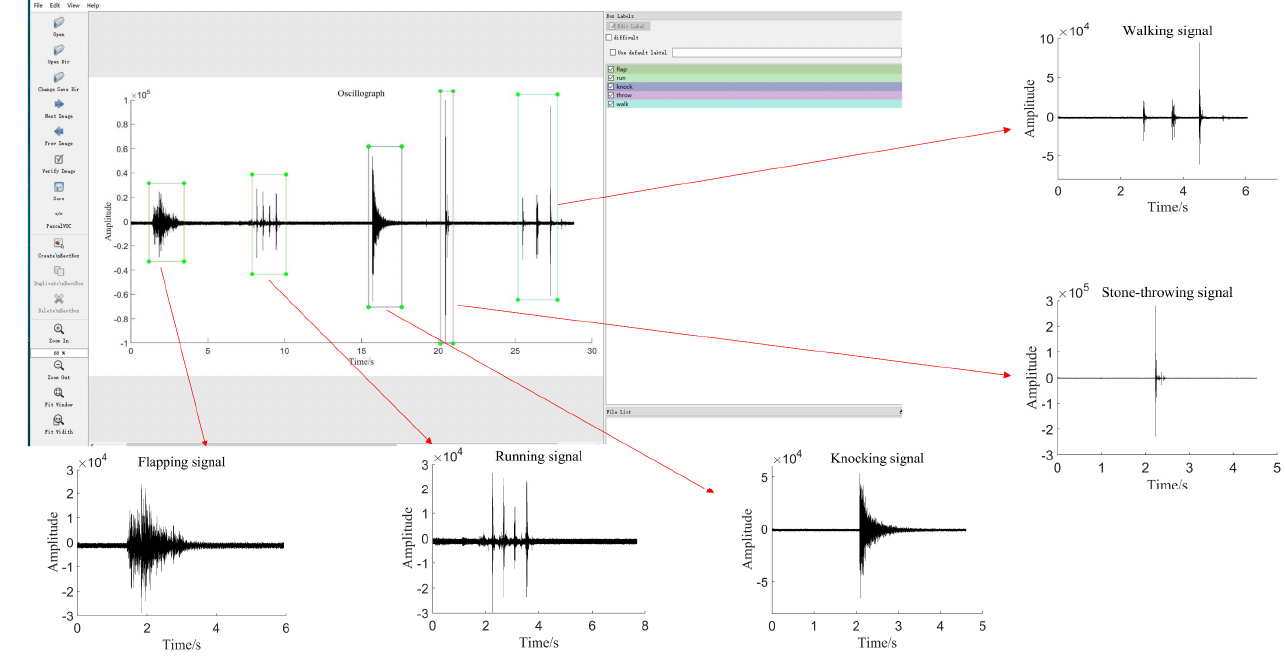
Figure 6. Annotation of the oscillograph dataset.